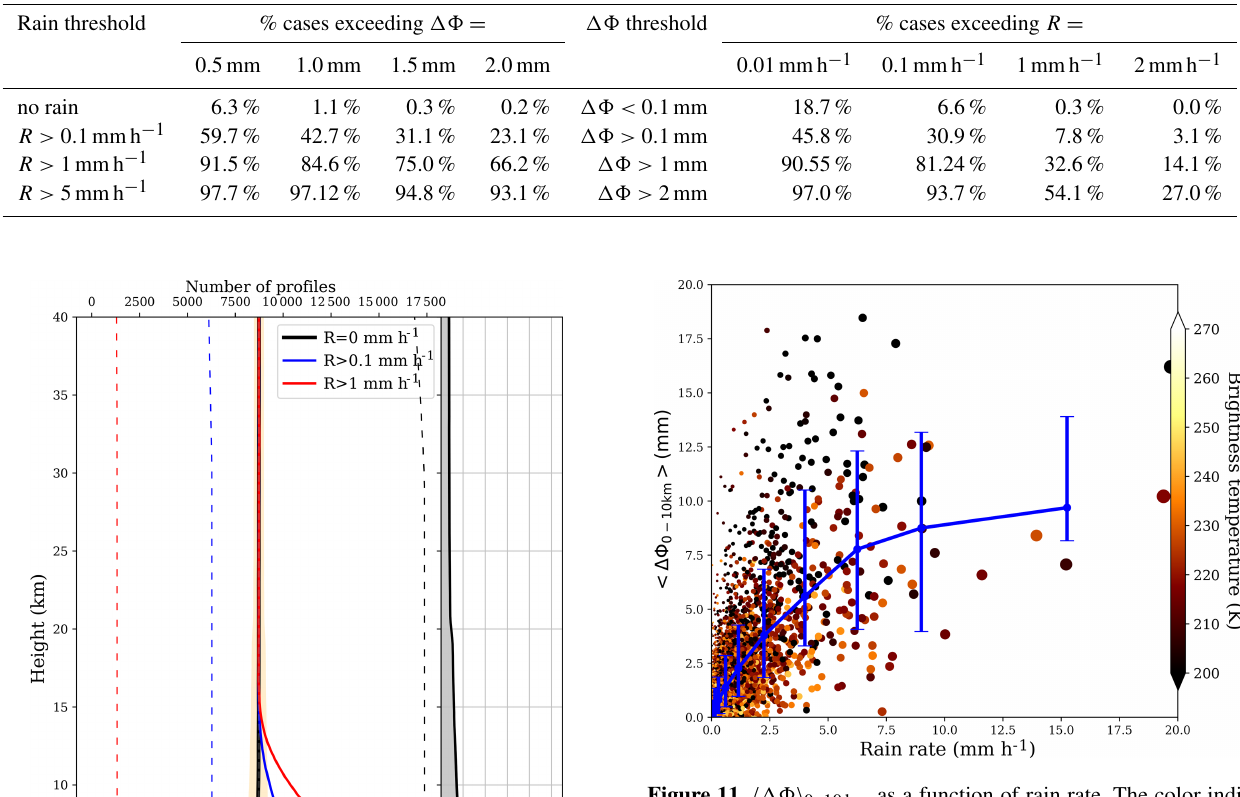
Figure 11. (cid:104) (cid:49)(cid:56) (cid:105) 0–10km as a function of rain rate. The color indi- cates the minimum T b for every case. The solid blue line represents the mean of all the data inside precipitation bins. The error bars comprise 85% of the